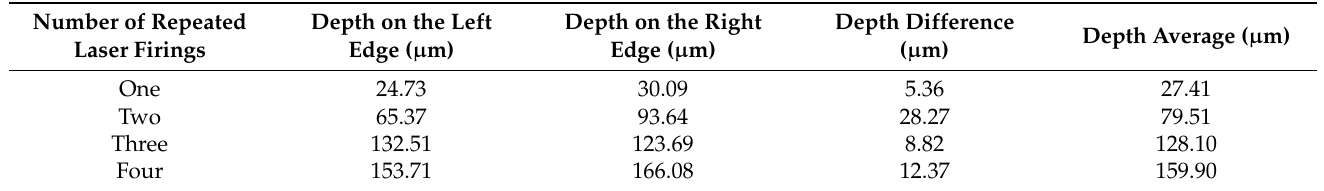
Table 7. The measured depth values after different numbers of repeated laser firings with the 4w_30k_100_re10 recipe. Number of Repeated Laser